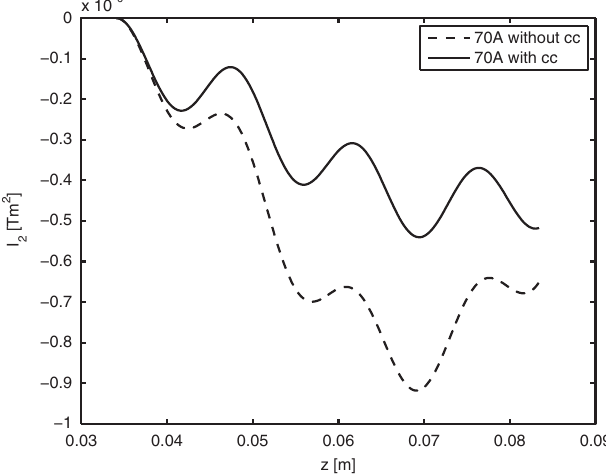
FIG. 9. Improvement in the second field integral caused by the loop system for I main ¼ 70 A . The second field integral was calculated from the first to the last extremum covered by the loop system.